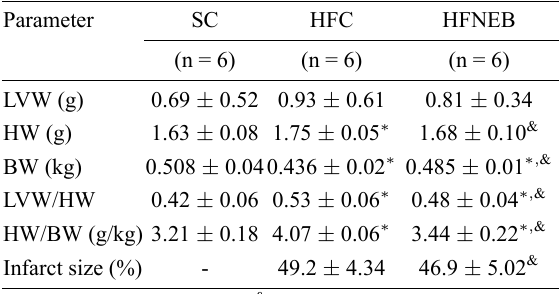
Table 1. General characteristics of the